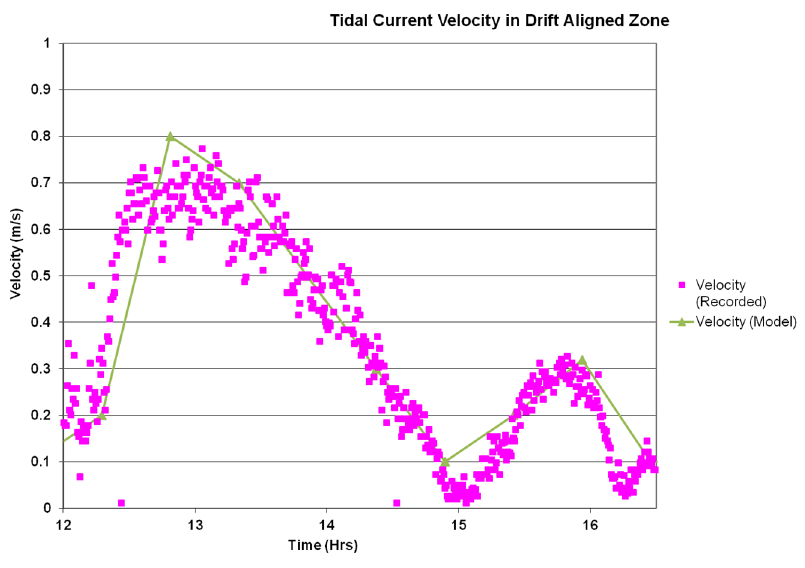
Figure 5. Recorded and simulated tidal current velocity in drift aligned zone.